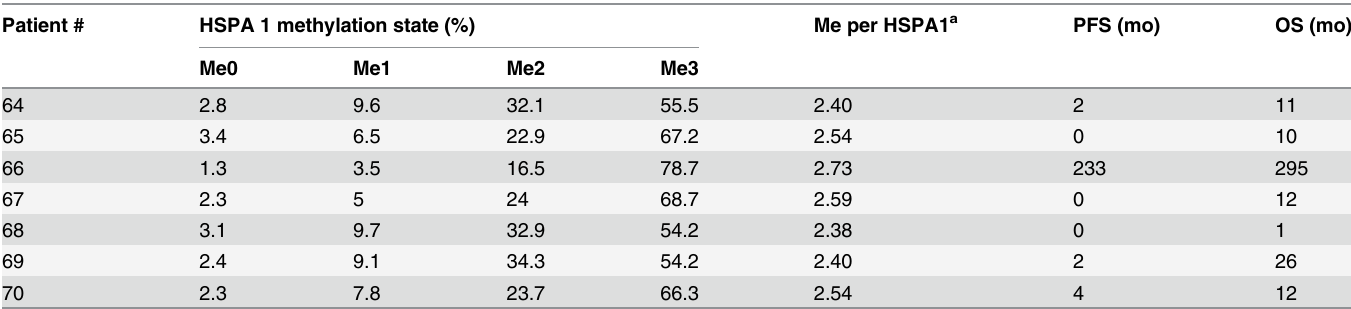
S1 Fig. Total methylation of Lys-561 in HSPA1 plotted versus overall (A) and progression- free (B) survival of HGSC patients. The curves were generated based on the data in Table